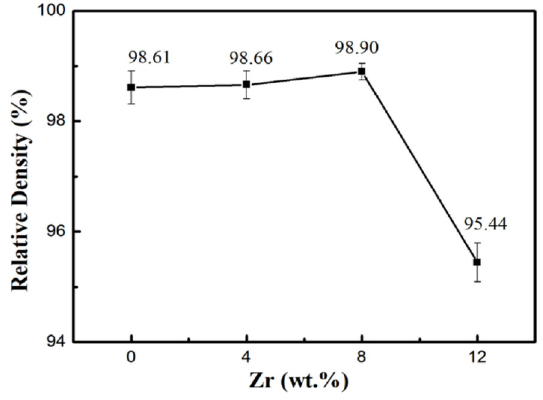
Figure 6. Relative density of Ti-30Mo-0.5TiC-xZr